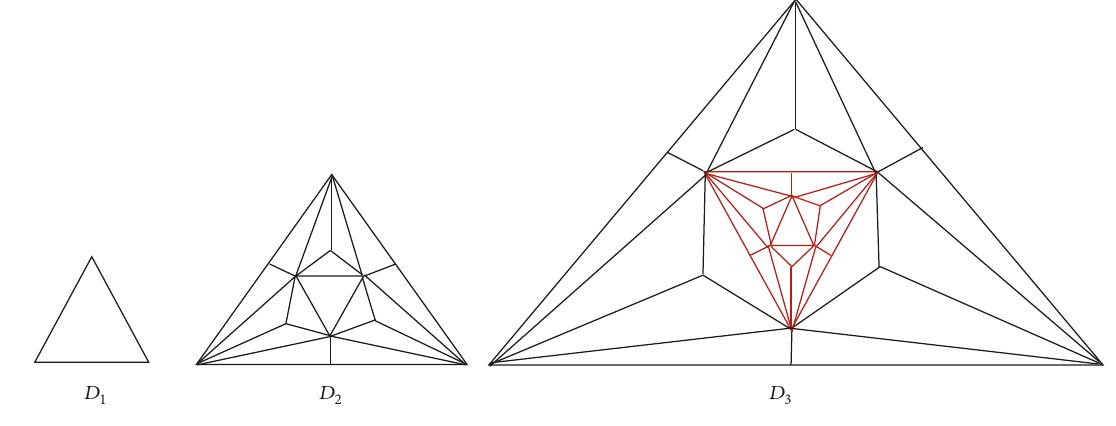
Figure 7: The first three graphs of 𝐷 𝑛